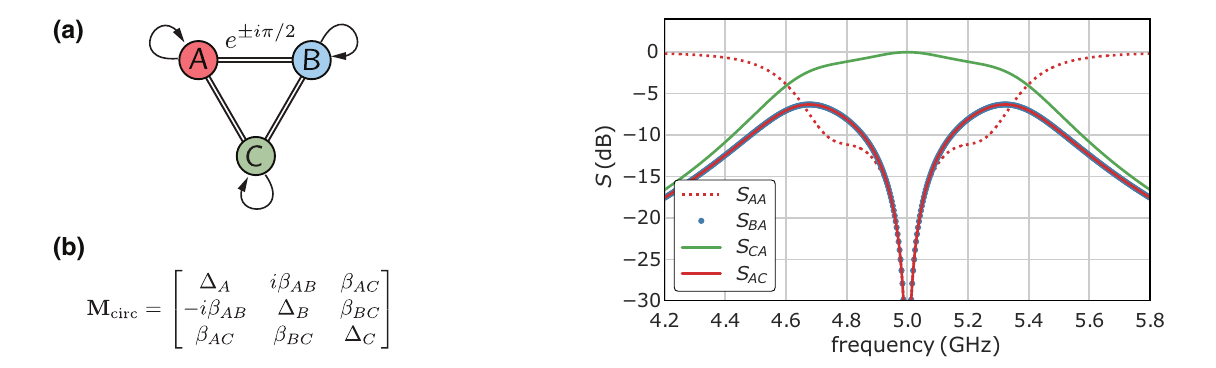
FIG. 6. S parameters of the three-mode parametric circulator, calculated using Eq. (8). The frequency axis is referenced to the signal port A